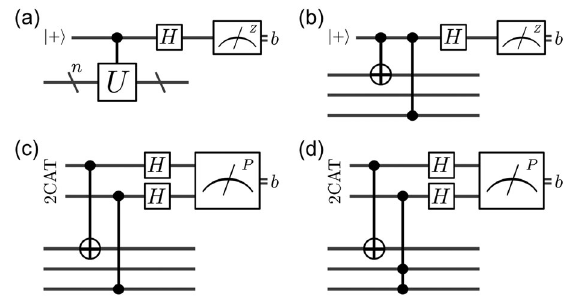
FIG. 1. (a) The method to measure a Hermitian and unitary n - qubit operator U [26]. When the result of the Z -basis measure- ment is b ¼ (cid:2) 1 , the state of the lower qubit is projected into the (cid:2) 1 eigenspace of U . (b) The method applied to measuring a Pauli XIZ on three code qubits. (c) The method made fault tolerant by using a verified 2-qubit CAT state, 2 CAT ¼ ðj 00 i þ j 11 iÞ = [27]. The measurement is now of the parity of the ancilla